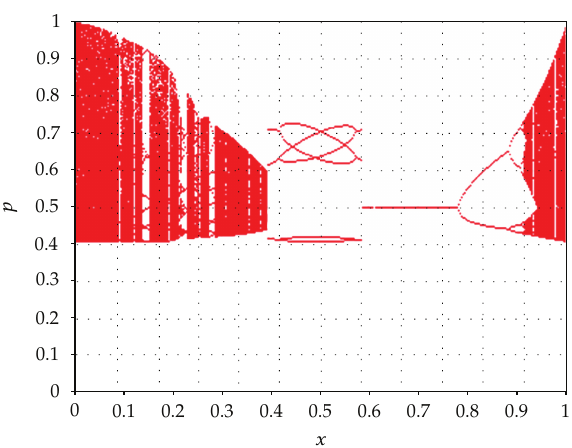
Figure 9: Grab the dollar game—bifurcation diagram.